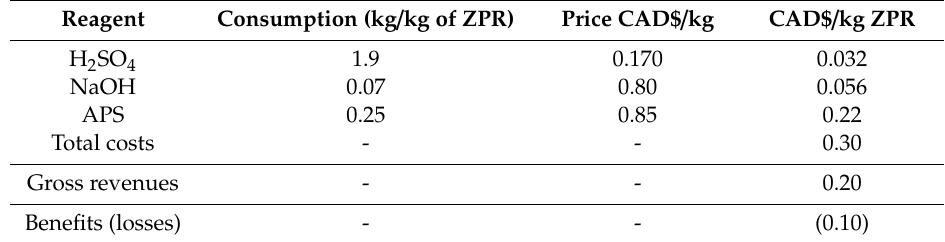
Table 11. Preliminary estimation of the operating costs for the ZPR-Co process of Figure 9. (The reagent prices were obtained from quotations dating of 2019 and are used here only to give an order of